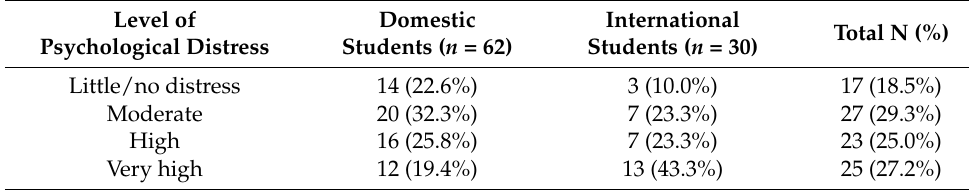
Table 5. Level of psychological distress (N =